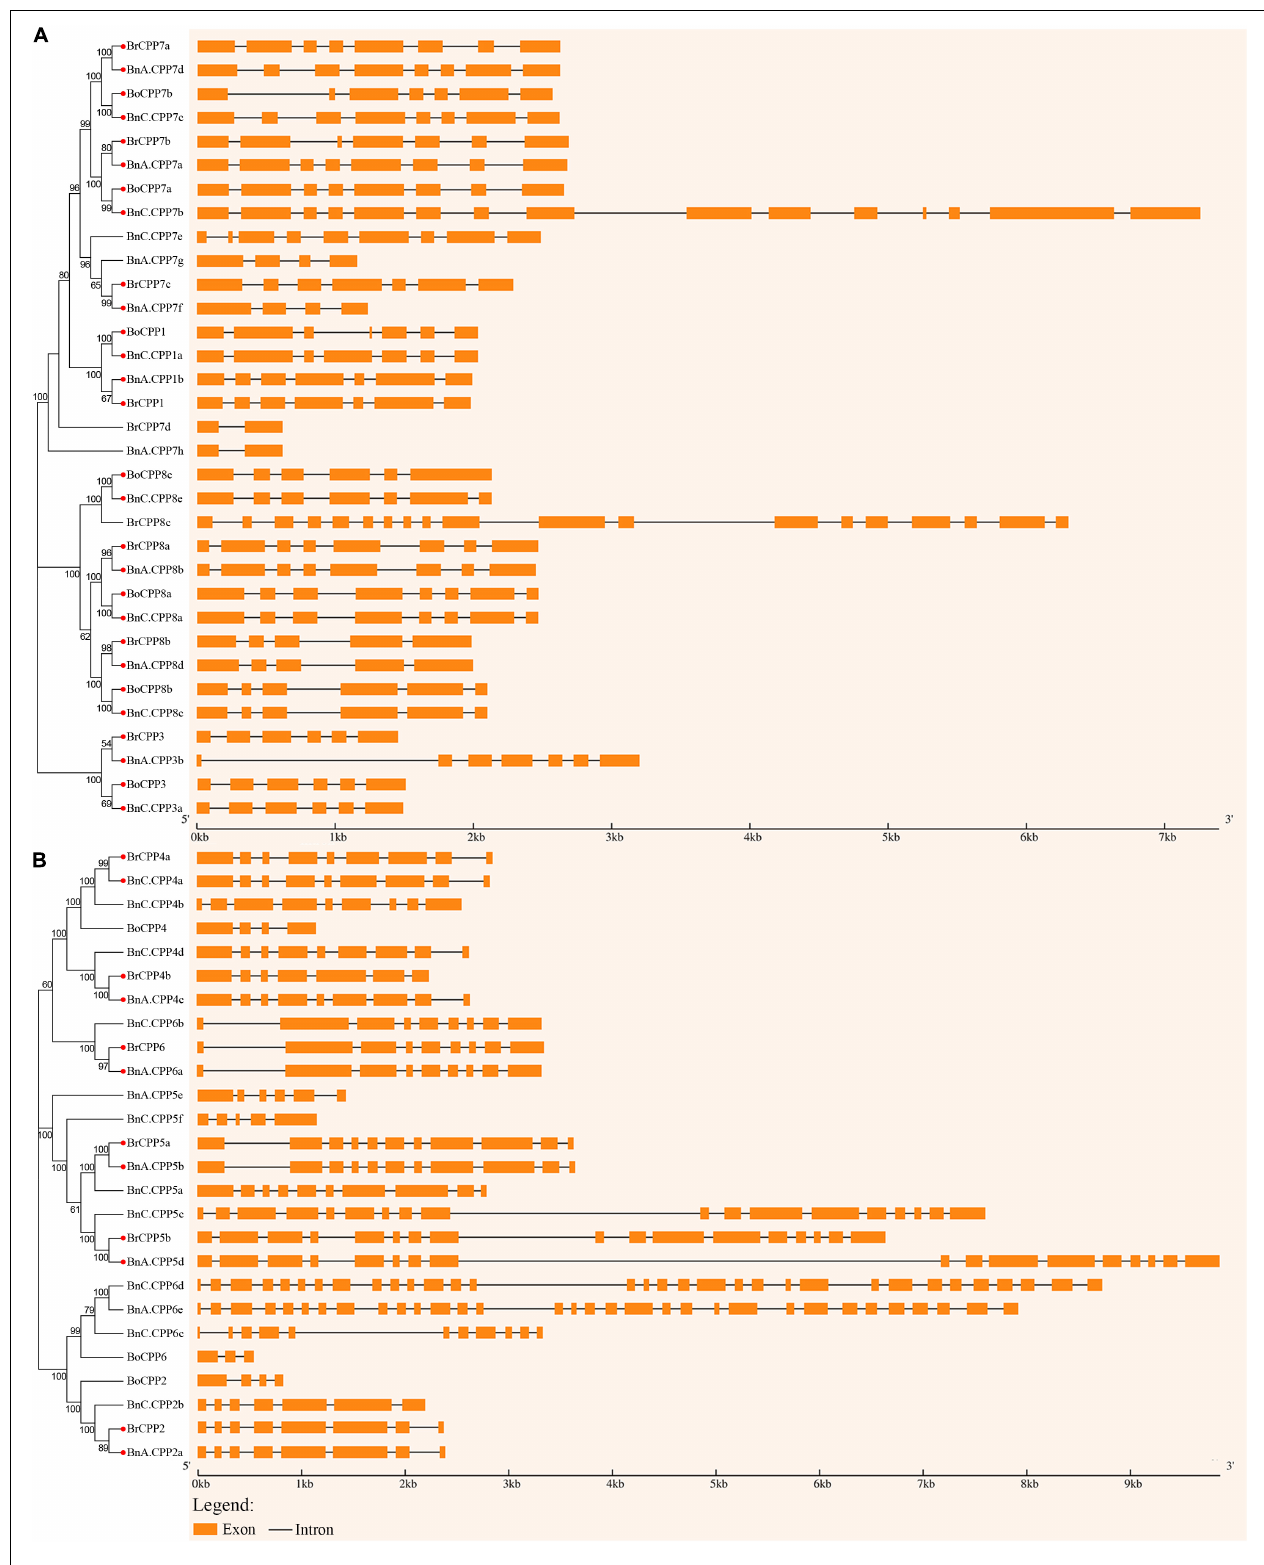
FIGURE 4 | Intron-exon structure of the CPP genes in B. napus and diploid progenitors. The genes on two clades, I (A) and II (B) , of the phylogenetic tree were shown separately. The red circle indicates orthologs with potential direct evolutionary relationship.